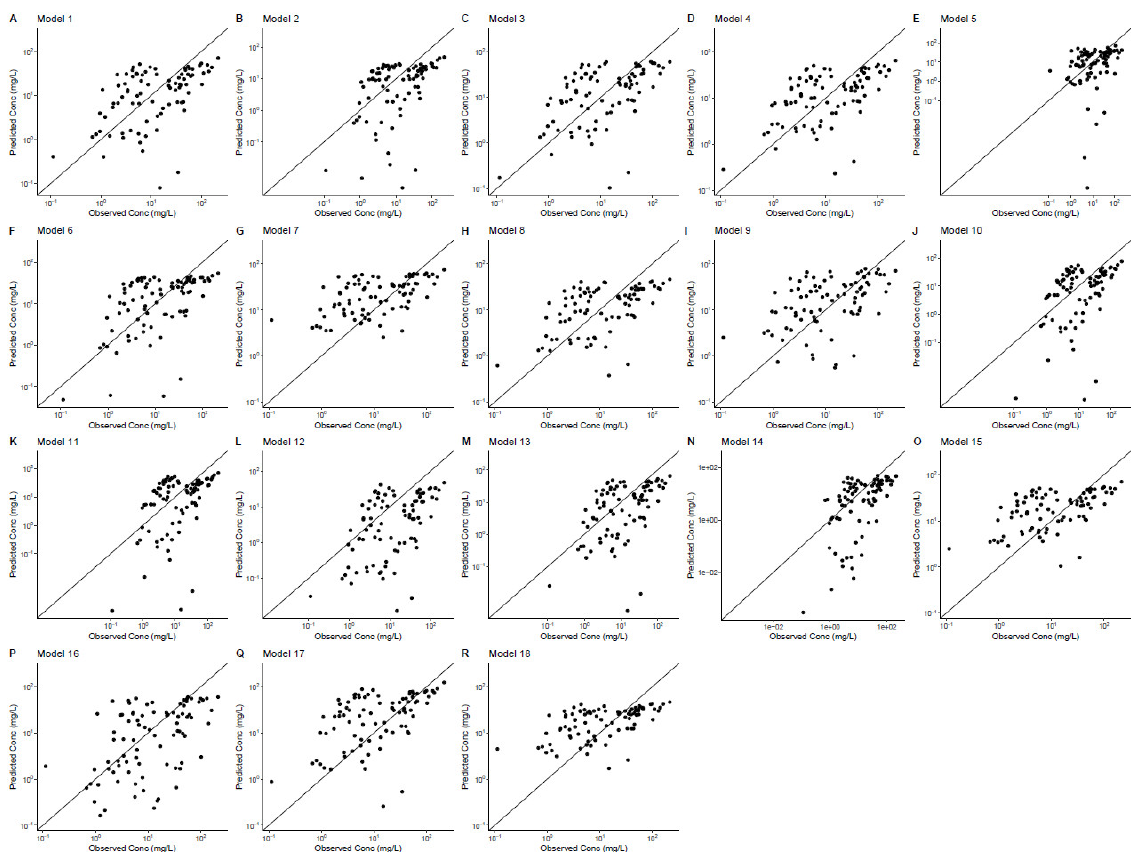
Figure 2. The goodness-of-fit plots of the 18 models. Population predictive concentration (y-axis) versus observed concentration (x-axis). The individual prediction versus observation GOF plots are shown in Figure 3. The GoF plots of the individual predictions showed a major improvement compared to the population predictions. Most of the points in Figure 4 were evenly distributed around the unity line. Among these models, models 4, 10 and 13 outperformed the other models and showed a good match between predicted and observed concentrations. Model 4, 10 and 13 were all two-compartment models. Both these three models used CRCL (CG) as a co- variate on CL. In addition, model 10 used an APACHE score as covariate on Q and model 13 used total body weight as a covariate on V1.